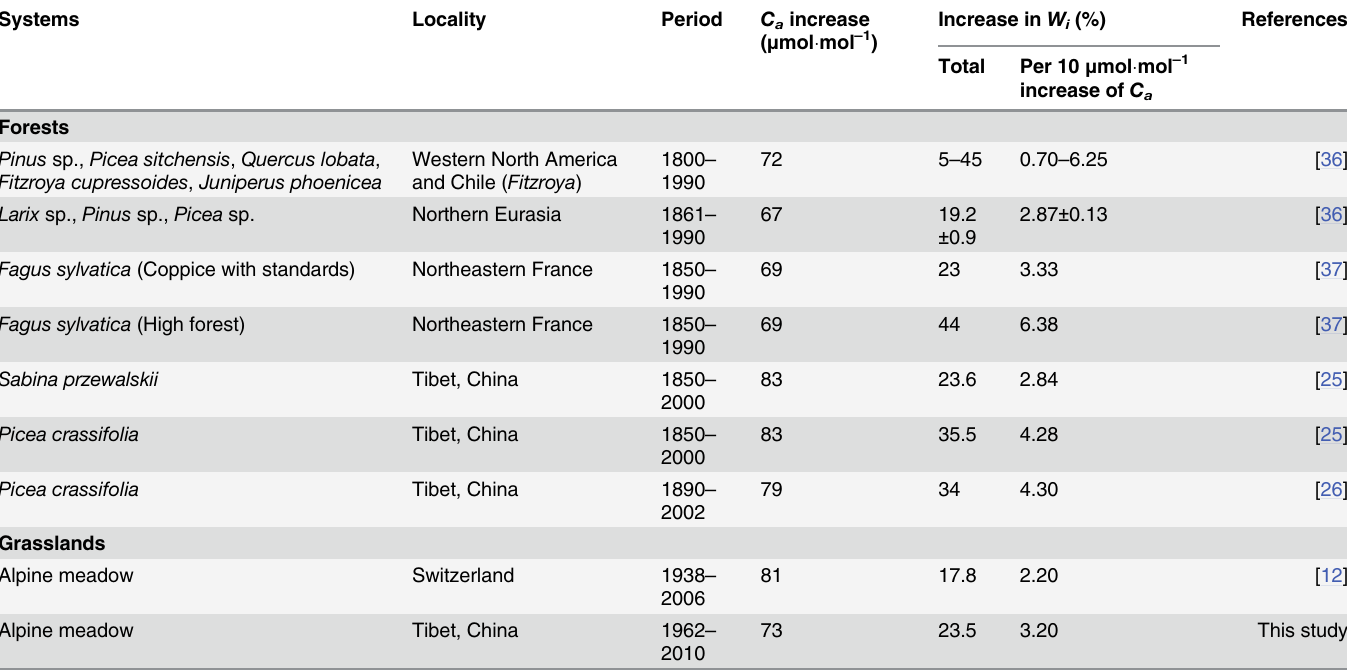
Table 1. Long-term changes in intrinsic water use efficiency ( W i ) of trees and alpine meadow and in atmospheric CO 2 concentration ( C a